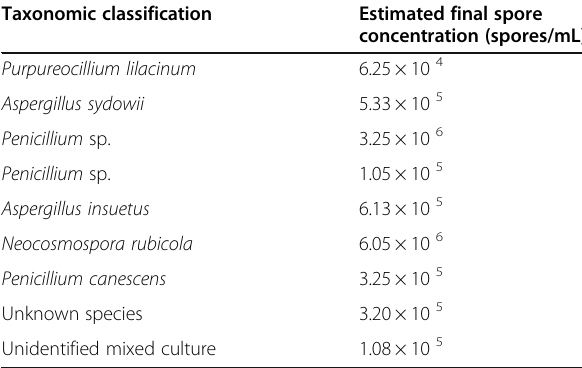
Table 1 Fungal strains included in the fungal suspension used for egg